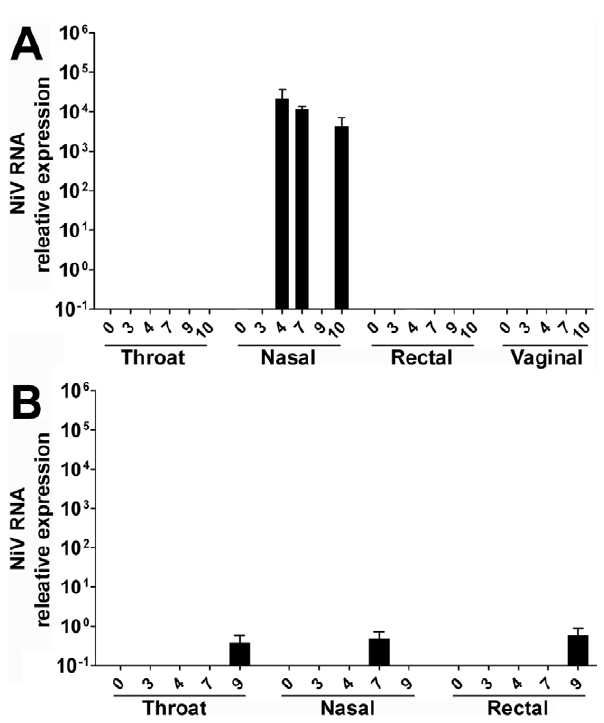
Figure 7. The relative quantity of NiV RNA detected by Taqman RT-PCR. Shown are the results from nasal, pharyngeal, rectal, and vaginal swabs from challenged AGM specimens at a series of time points during infection. (A) Medium challenge dose, Subject 3; (B) High challenge dose, Subject 1.